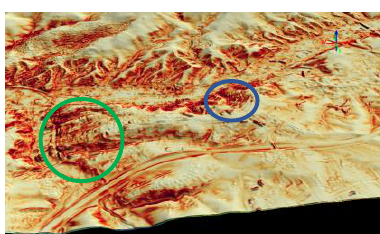
Figure 21. Important focal area for city planning in South